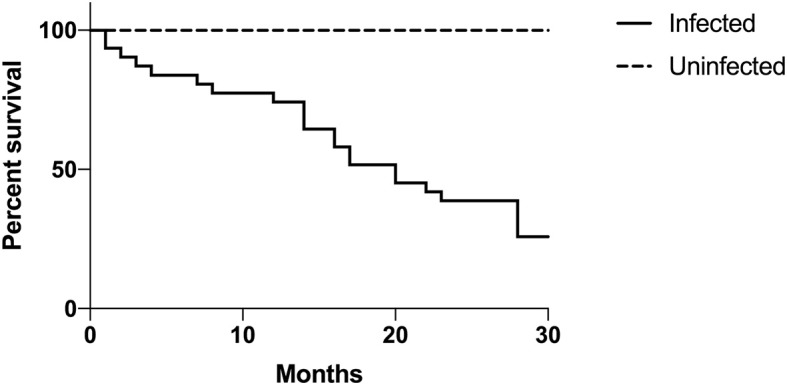
Infected snakes are statistically more likely to experience mortality than uninfected snakes. Longitudinal assessment of mortality between infected and uninfected snakes in collection A. Time is represented in months and begins at the onset of a serpentovirus outbreak (September 2016). Kaplan-Meier survival curve; p-value = 0.001.